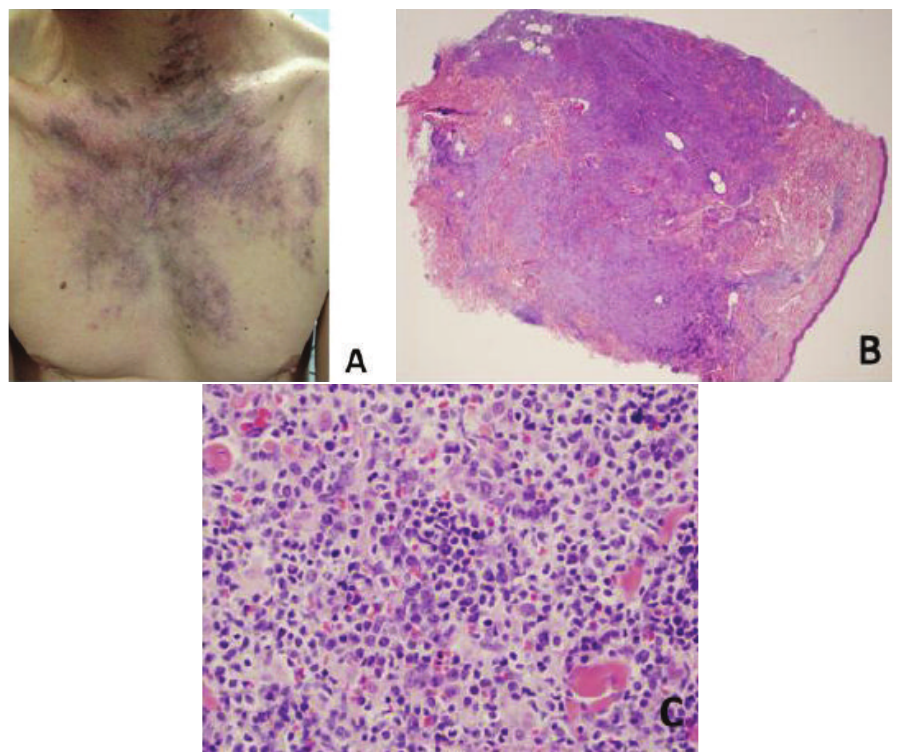
Figure 2: Chest skin lesion. (A) Clinical photo of violaceous skin lesion on the patient’s chest. (B) Punch biopsy, H&E, 2x. MZL cells invading the dermis. (C) Punch biopsy, H&E, 40x. Small lymphoid cells consistent with MZL are observed here, but also the larger, more hyperchromatic cell population with many mitotic figures, similar to findings in the transformation areas of neck mass.